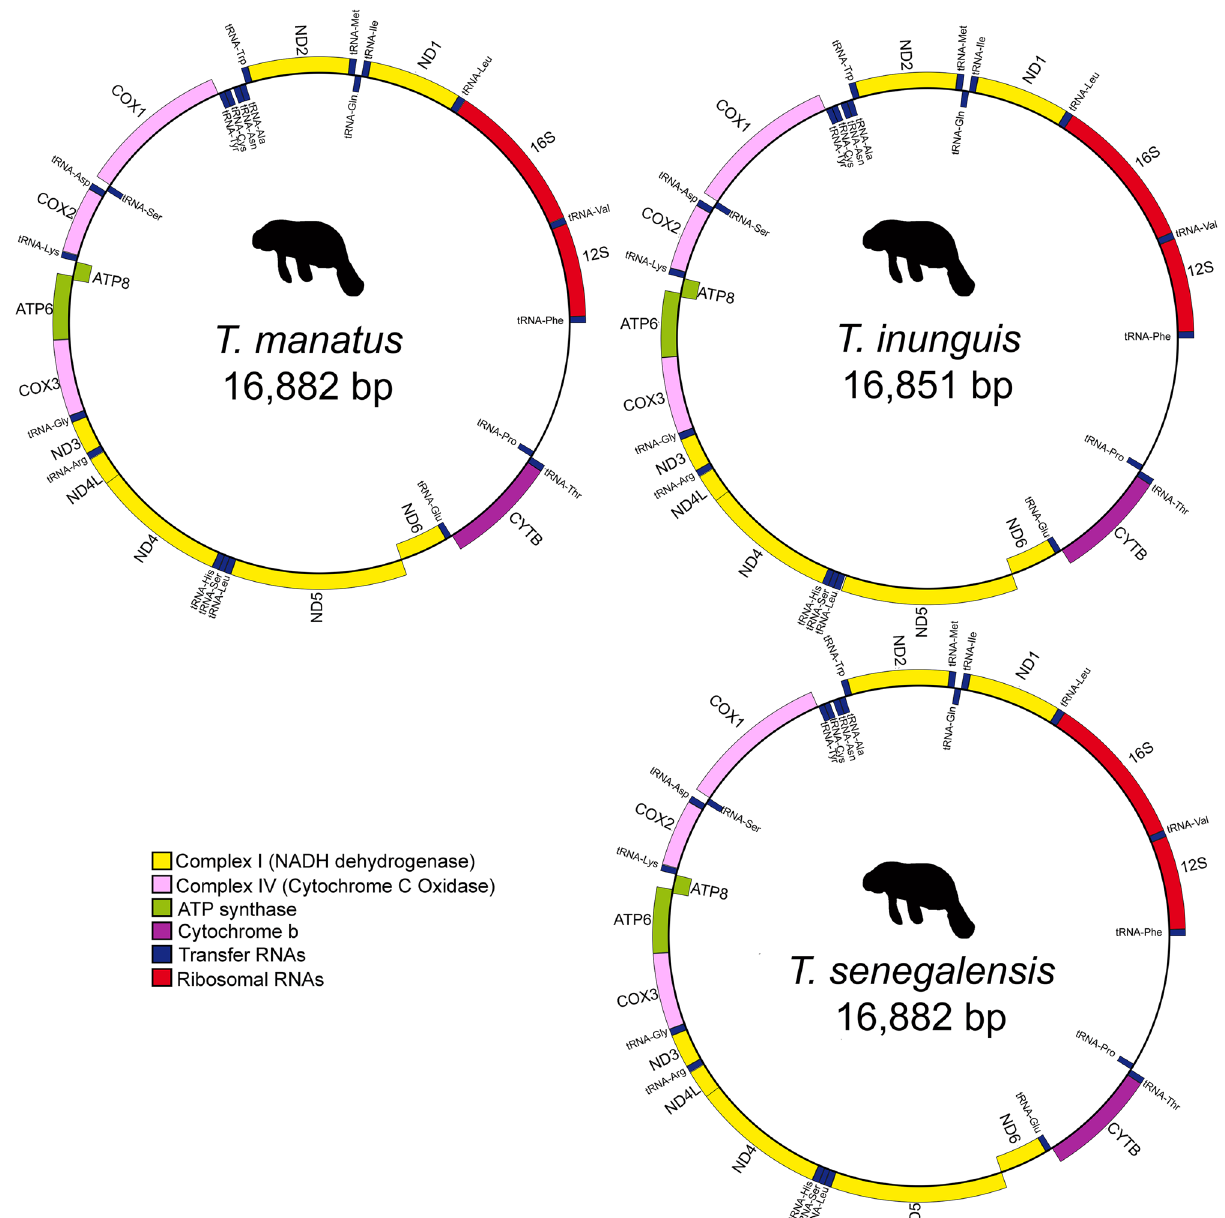
Figure 2. Scheme of circular mitochondrial genome of Trichechus species: 13 protein-coding genes, 2 ribosomal RNA genes, 22 transfer RNA genes, and the putative control